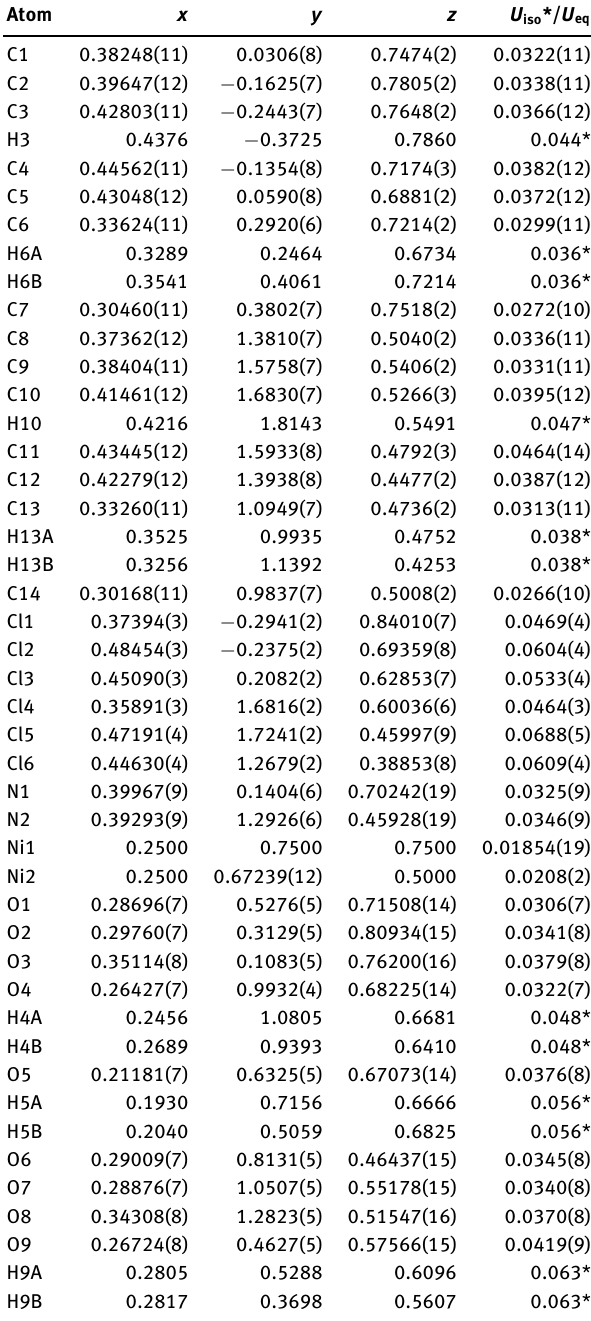
Table 2: Fractional atomic coordinates and isotropic or equivalent isotropic displacement parameters (Å 2